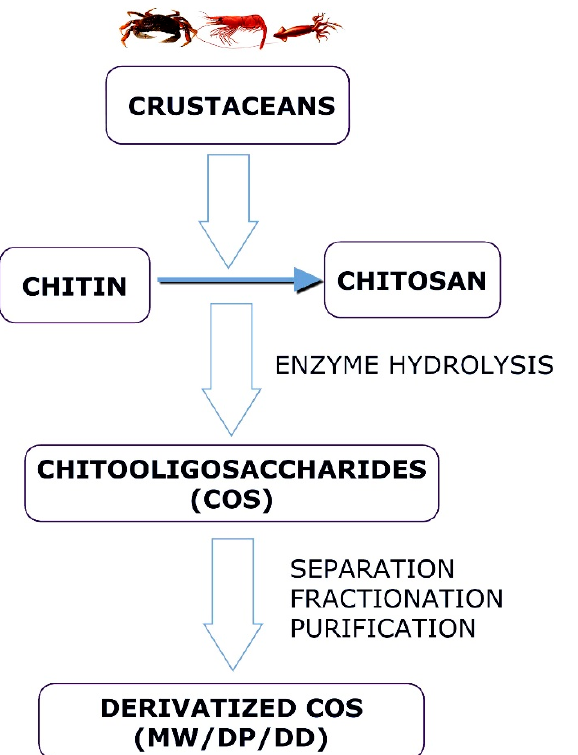
Figure 3. Schematic diagram showing the major steps in obtaining Chitooligosaccharides (enzy- matic synthesis).